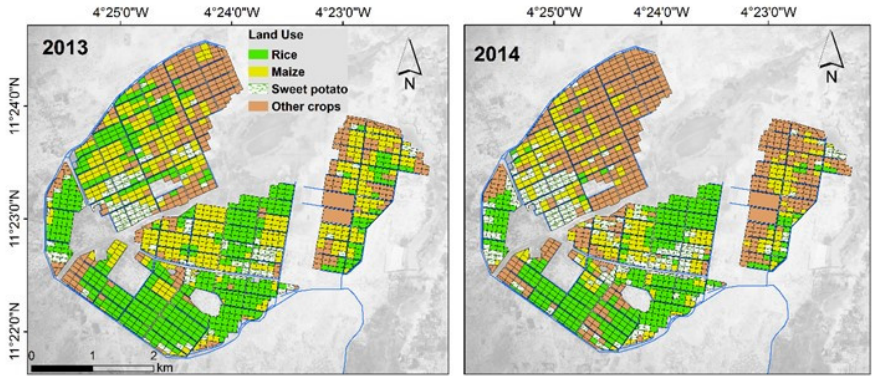
Figure 4. Land use across the Kou Valley irrigation scheme during the dry season production period in 2013 and 2014.